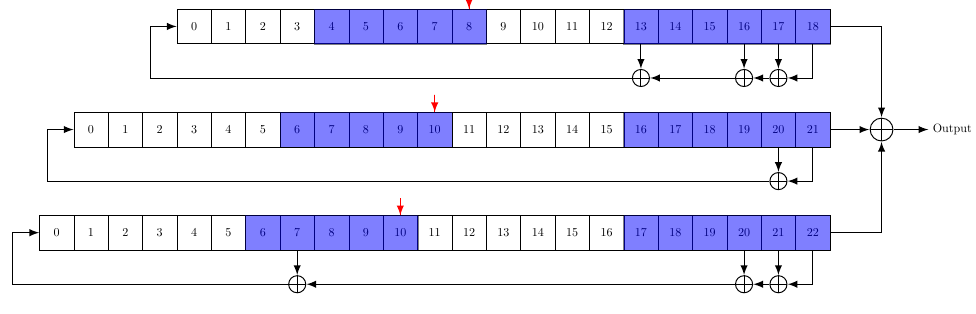
Figure 1: Description of A5/1 (source: [Jea16]). The 33 blue bits are the one required to compute the first 5 keystream